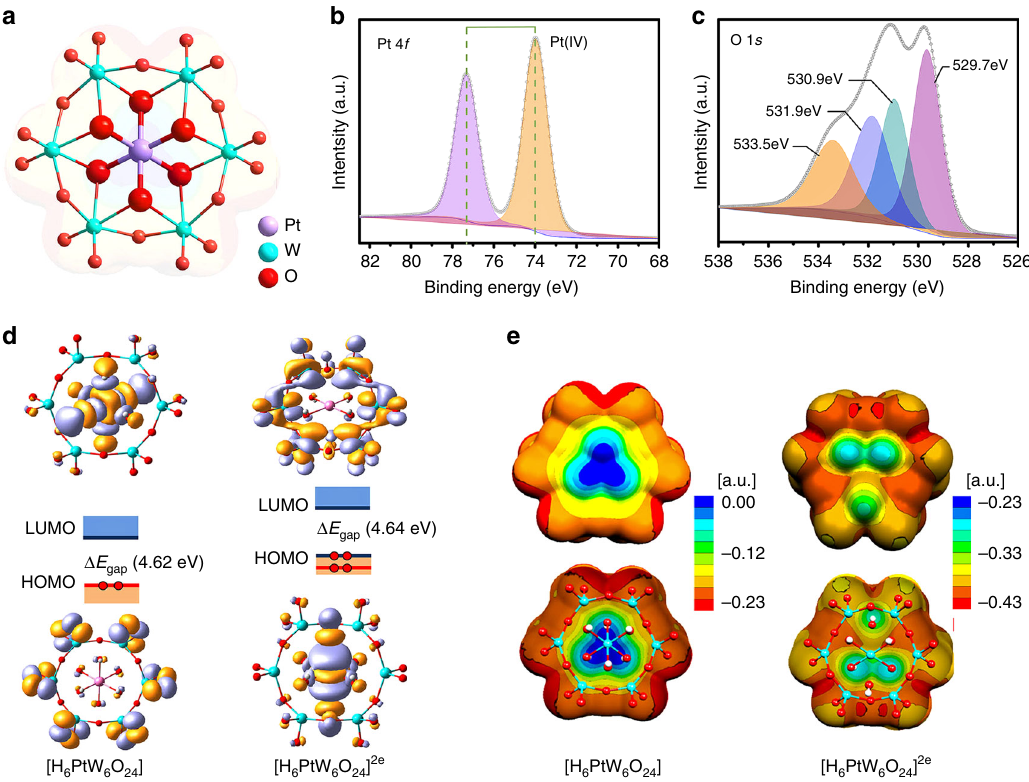
Fig. 1 Structure and electronic properties of PtW 6 O 24 . a The ball and stick representation of PtW 6 O 24 with the corresponding semitransparent map of molecular electrostatic potential (MEP). b , c High-resolution XPS spectra of Pt and O for PtW 6 O 24 . d 3D representation of the highest occupied molecular orbital (HOMO) and the lowest unoccupied molecular orbital (LUMO) for [H 6 PtW 6 O 24 ] and [H 6 PtW 6 O 24 ] 2e . Additional reduced states are given in Supplementary Fig. 14. e Full and one-half views of the MEP distribution for [H 6 PtW 6 O 24 ] and [H 6 PtW 6 O 24 ] 2e : the red and blue or green identify more and less nucleophilic regions for H + . Supplementary Table 6 discusses the proton